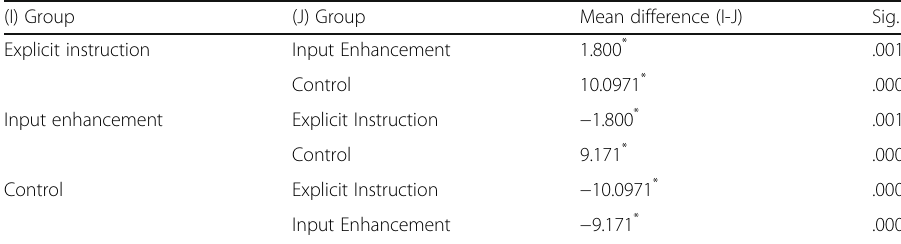
Table 3 Post Hoc tests using Tukey ’ s HSD test for the UGJT (I) Group (J) Group Mean difference (I-J)